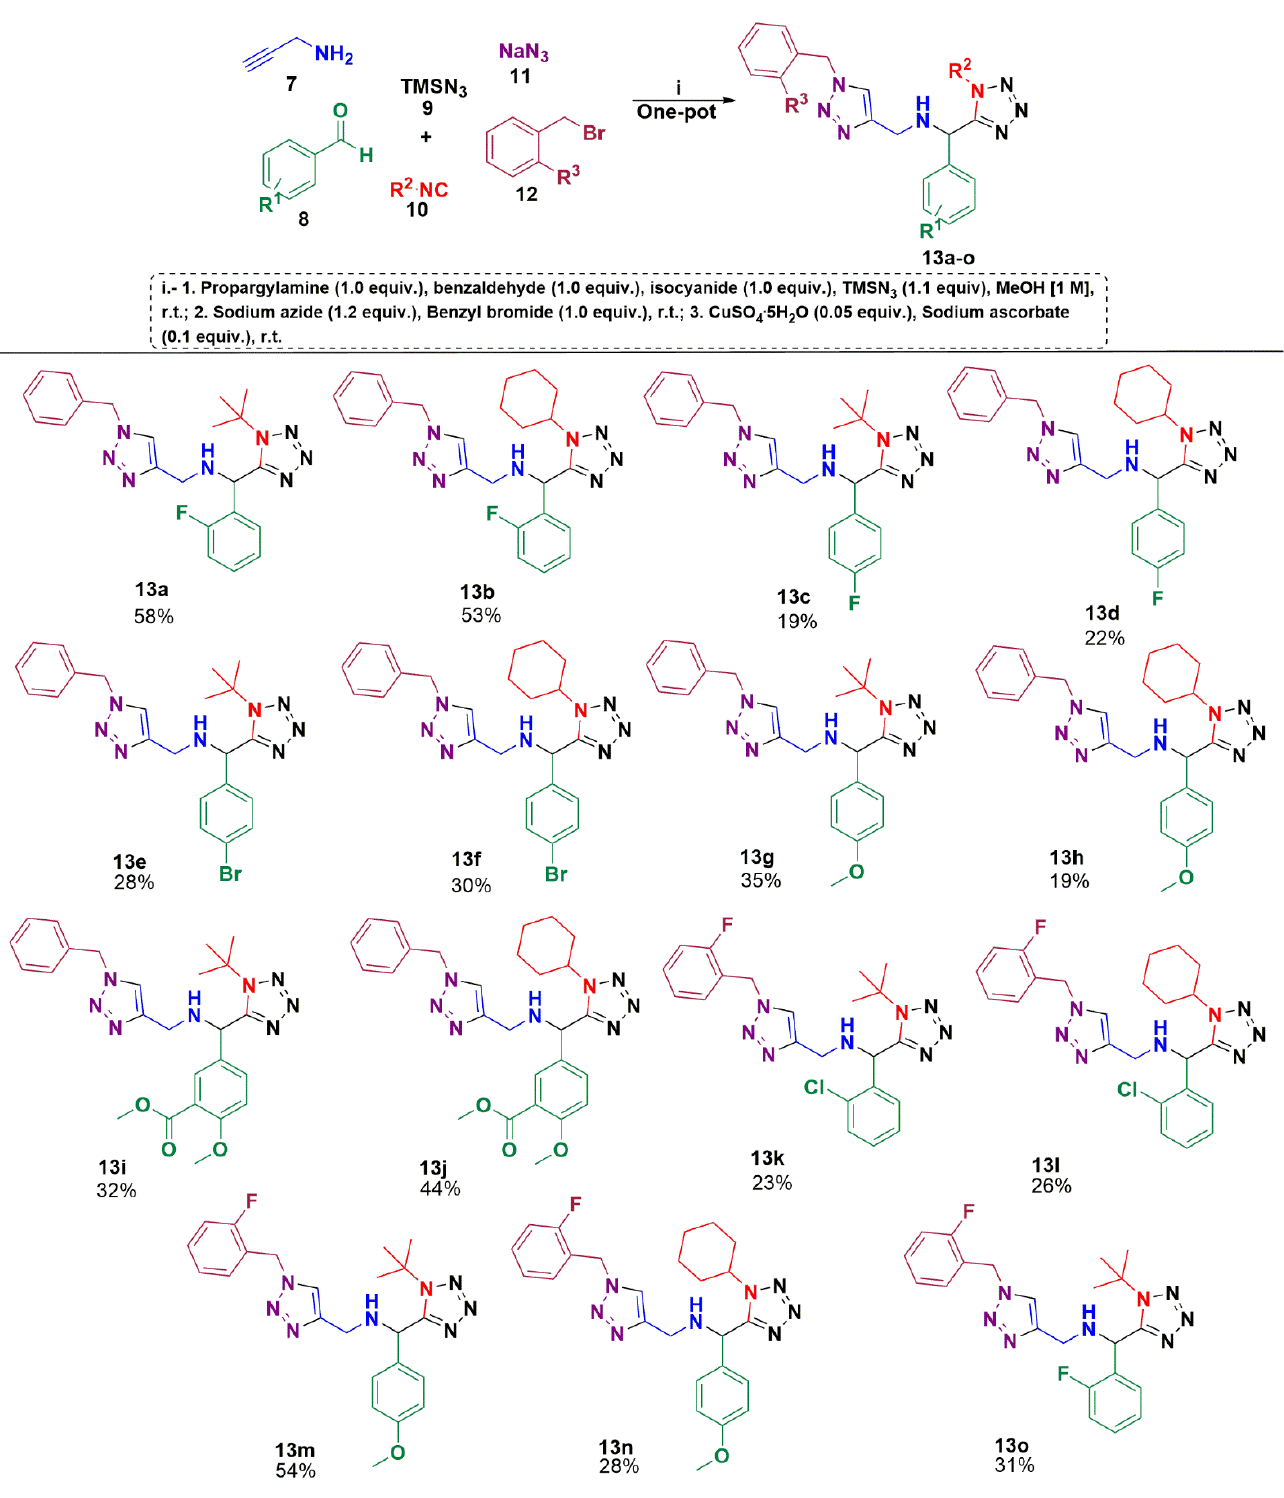
The cascade reaction mechanism behind the target molecules 13a – o is depicted in Scheme 2. First, propargylamine 7 reacts with benzaldehyde derivate 8 to give the imine 14 , which is protonated with HN 3 (generated in situ by proton exchange between TMSN 3 and methanol) affording the iminium ion 16 . This ion is trapped by the isocyanide 10 to give the nitrilium ion 17 , which is then attacked by the azide ion to afford the 1,5-DS-T